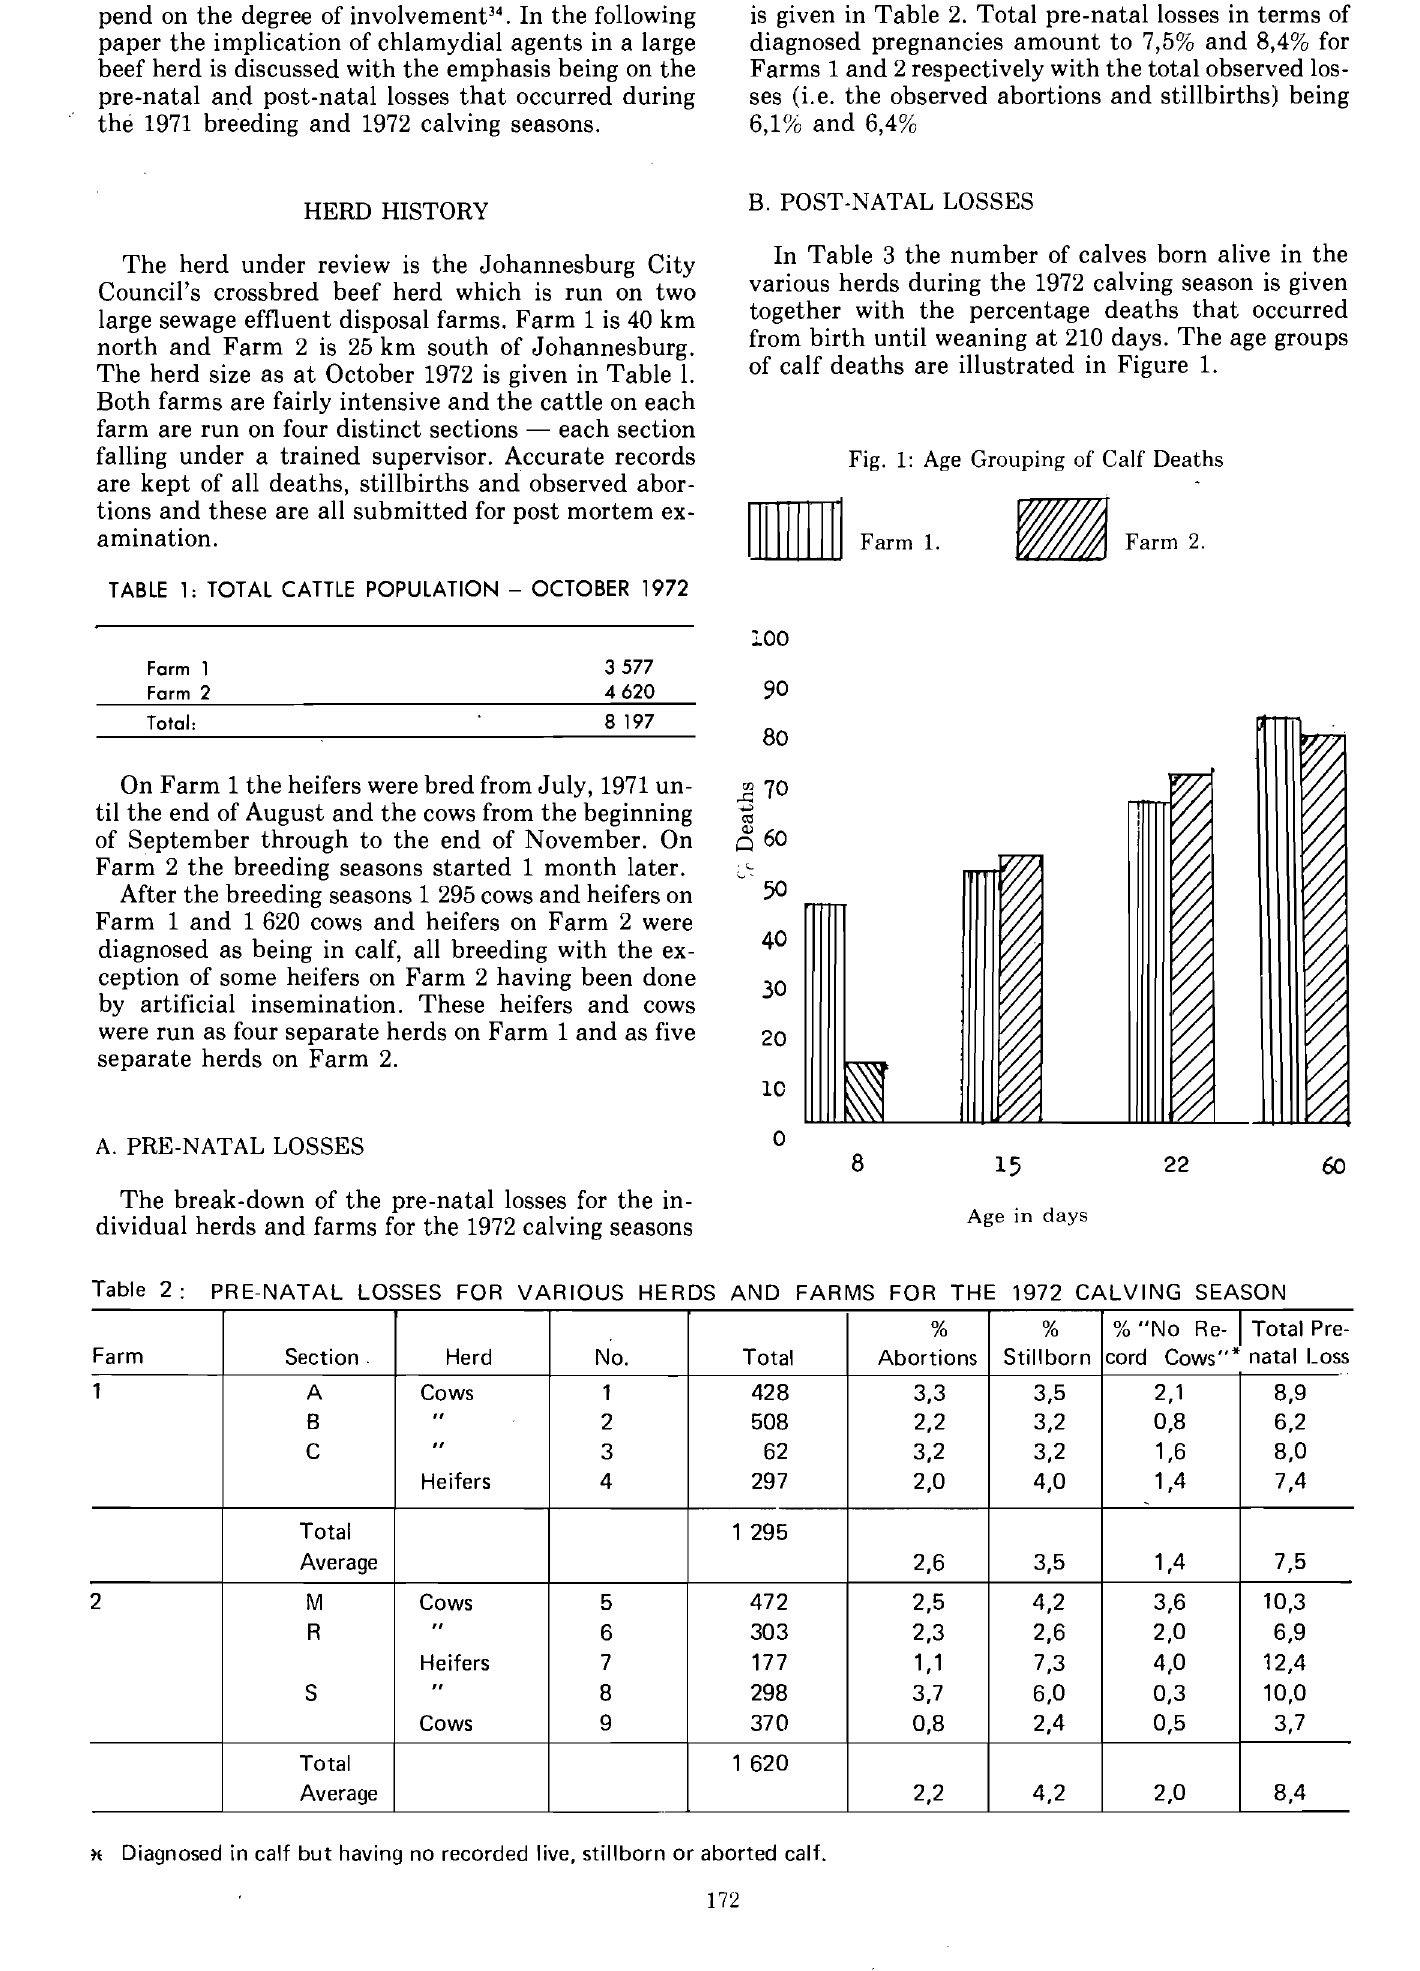
TABLE 1: TOTAL CATTLE POPULATION - OCTOBER 1972